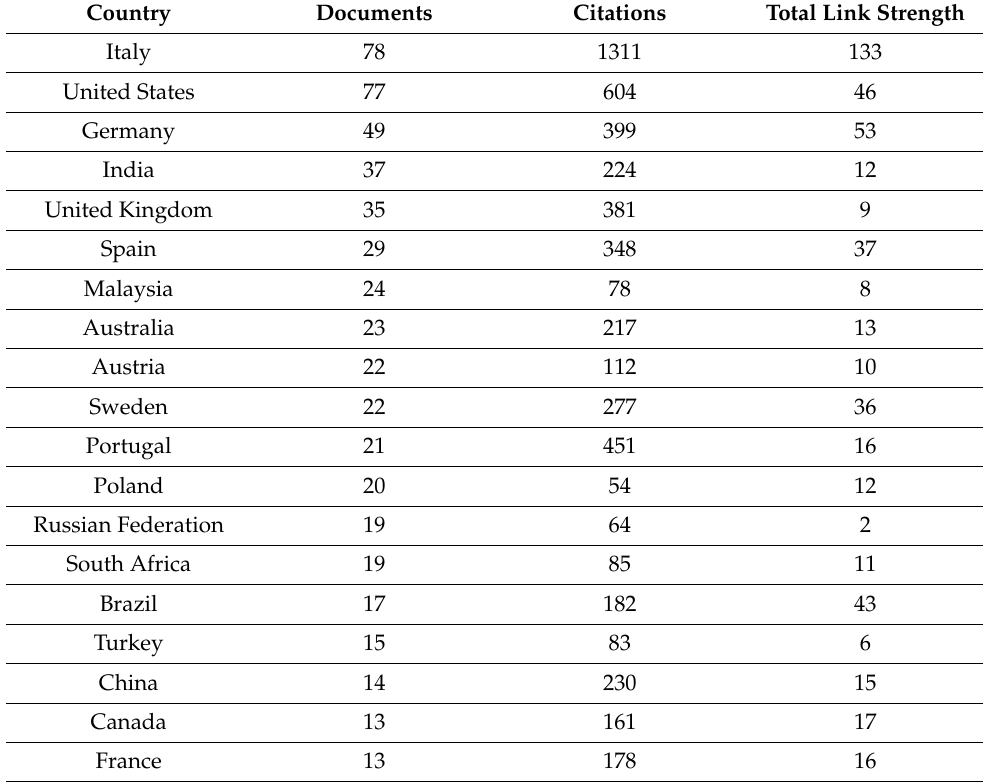
Table 3. Top twenty contributed countries in the given field.